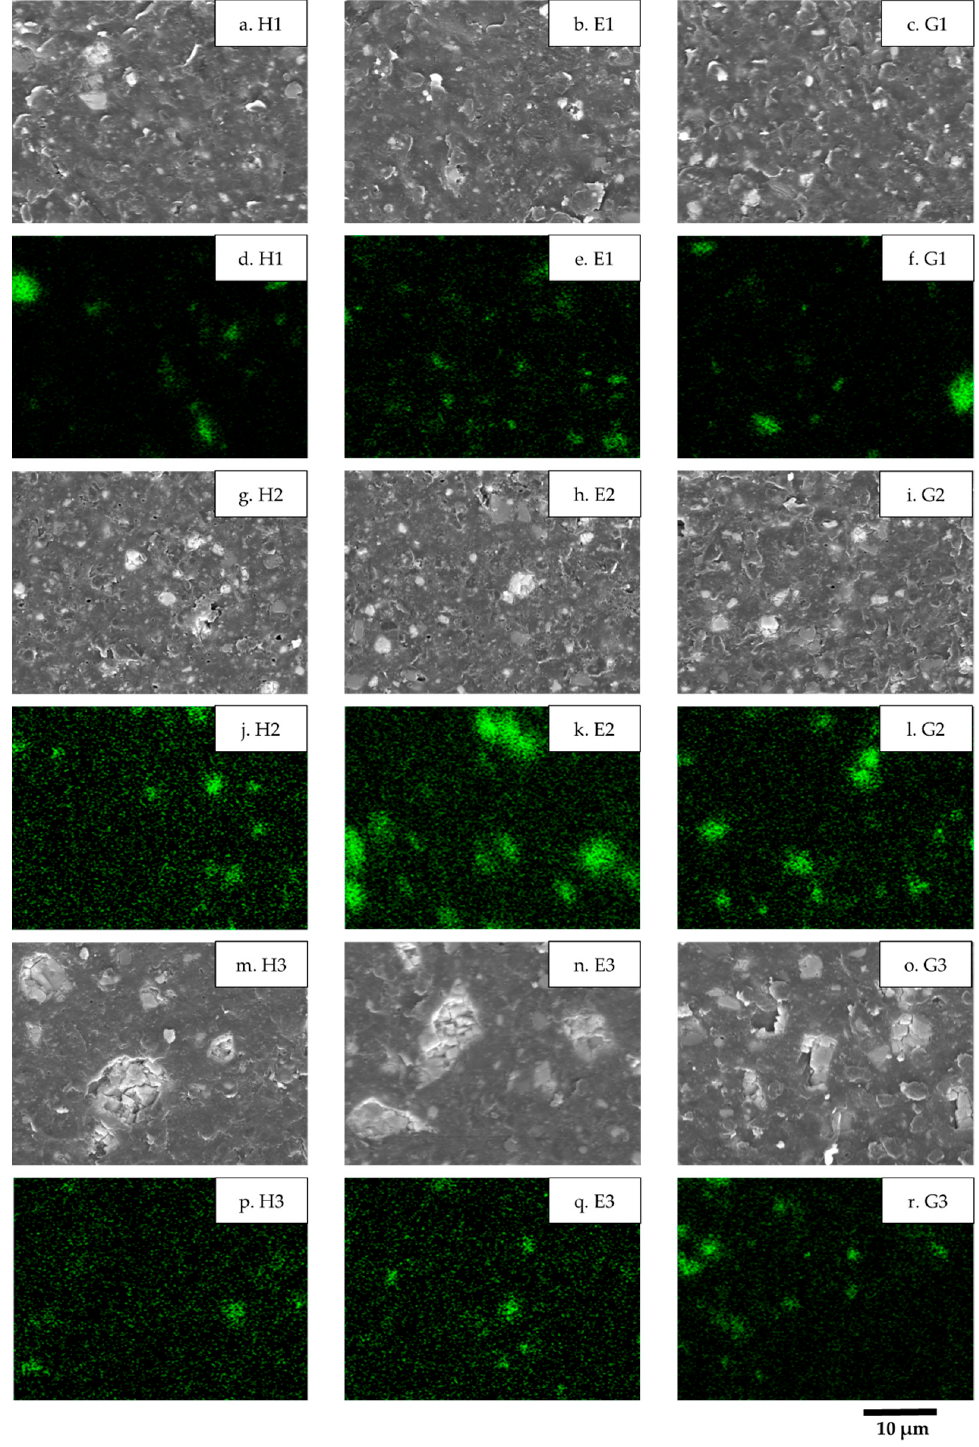
Figure 4. ( a – c , g – i , m – o ) SEM images of coating cross-sections, ( d – f , j – l , p – r ) EDS mapping of Al in the cross-sections.